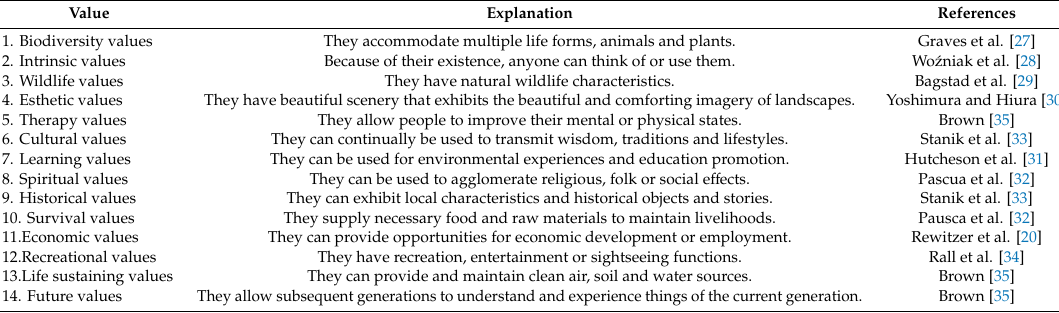
Table 1. Diverse values in cultural ecosystem services (CES)